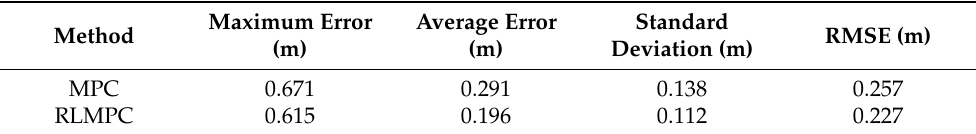
Figure 13. Tracking error comparison of MPC and RLMPC in Scenario 2. Table 4. Comparison of Path Tracking Performance of Scenario 2.